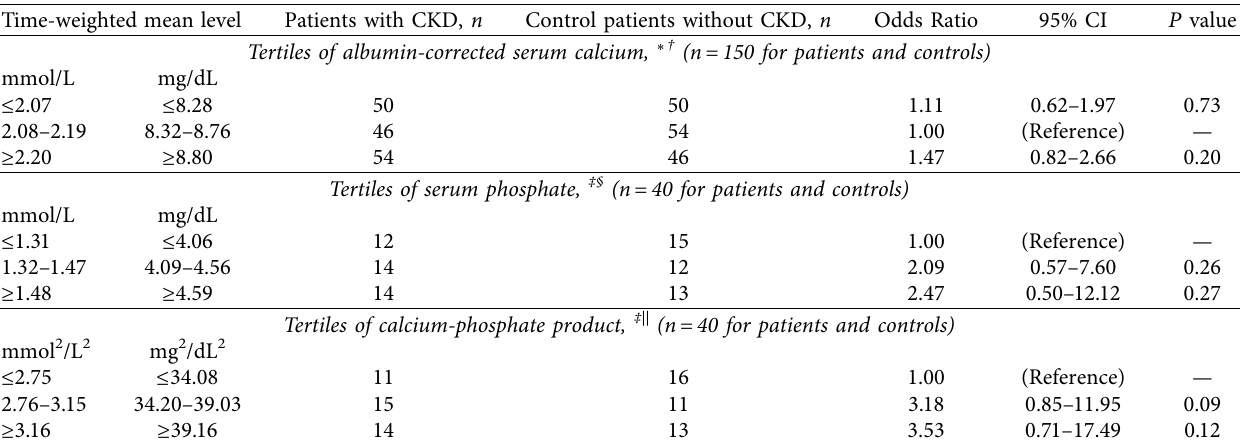
Table 4: Sensitivity analysis multivariable regression models of time-weighted albumin-corrected serum calcium, serum phosphate, and calcium-phosphate product and development of